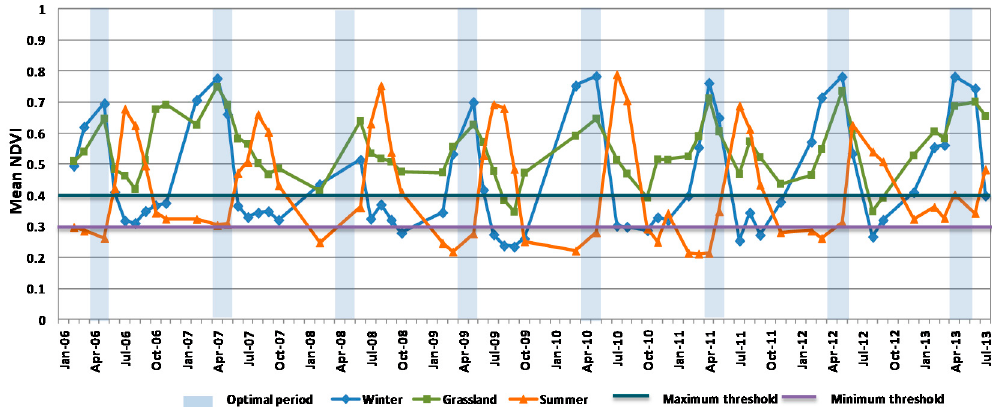
Figure 4. Mean NDVI profiles of all monitored plots for winter crop (blue line), grassland (green line) and summer crop (orange line) for 2006 to 2013. The optimal period (Days 90 to 150) appears in blue, the maximum threshold NDVI value in dark green and the minimum threshold NDVI value in purple.